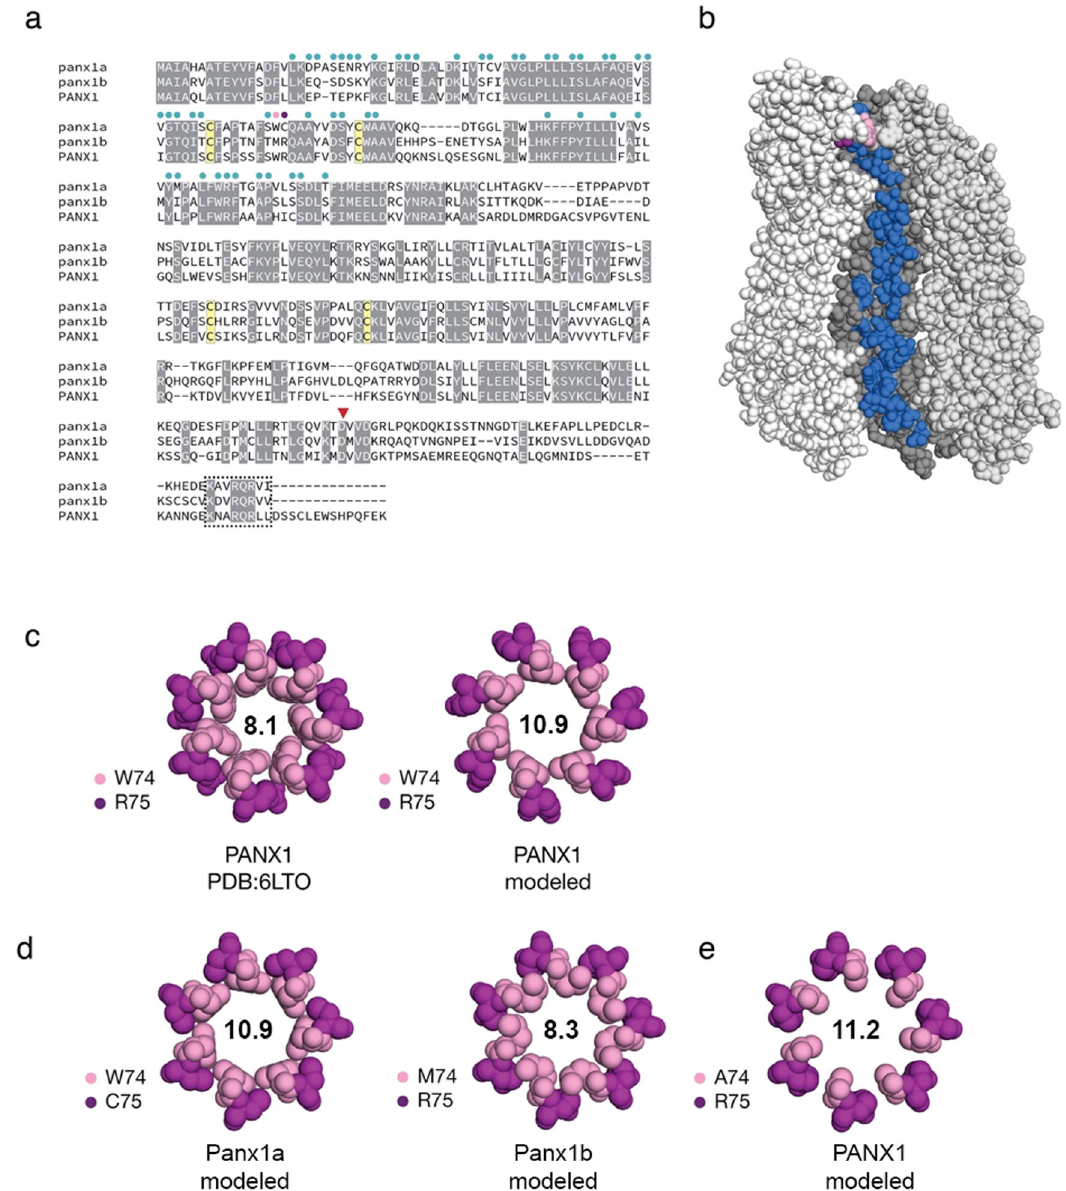
Fig. 9 Sequence and structural attributes of the zebra fi sh pannexins. a Protein sequence alignment of full-length human pannexin-1 (PANX1; amino acids (aa): 1-426) and zebra fi sh Panx1a (aa 1-416), and Panx1b (aa 1-422). Circles above the sequence alignment indicate amino acids that line the channel. Two amino acids at positions 74 and 75 form an extracellular gate (in pink and purple, respectively). Four cysteines (in yellow) contribute to two functionally important disul fi de bonds. A red triangle denotes a caspase cleavage site located in the carboxyterminal domain. A box indicates a conserved carboxy- terminal segment of unknown signi fi cance. b Amino acids that line the inside of the channel are shown on one monomer of heptameric human PANX1 (PDB: 6LTO; aa 1-341 55 ). The channel is oriented with the extracellular-facing side of the channel at the top. c The human PANX structure was used to model the extracellular gate of zebra fi sh Panx1a/Panx1b by substituting as required and repacking only amino acids 74/75 against a rigid backbone. As a control, human PANX1 was subjected to the same re fi nement and repacking protocol, creating a larger extracellular gate than the original cryo-EM structure. The diameters of the respective gates (in angstroms) are shown. d Molecular models of the extracellular gates of zebra fi sh Panx1a/Panx1b. Each protein bears one substitution relative to the human PANX1 structure. e An alanine was modeled to mimic a constitutively ATP-permeable state. Molecular graphics were produced with PyMOL v2.4.1 (Schrödinger,